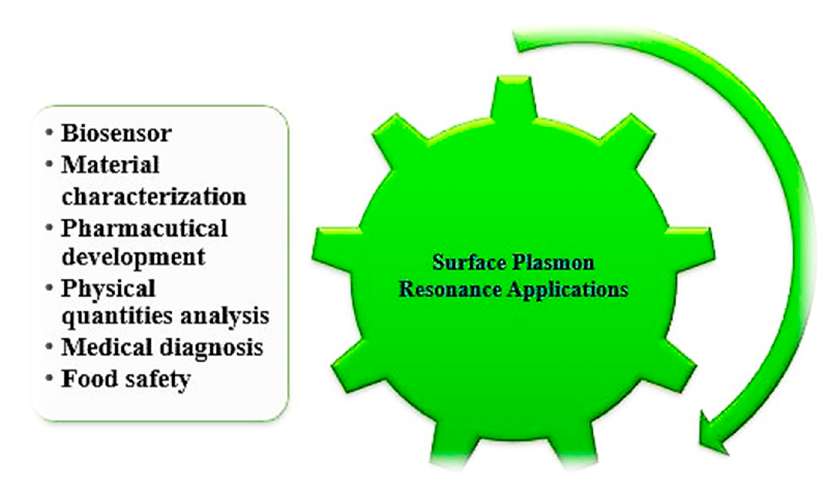
Figure 9. Applications of SPR sensors.